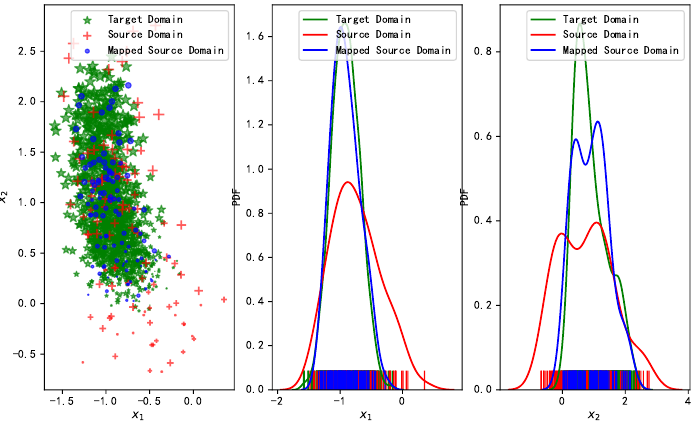
Figure 4. Fingerprint samples in the source domain, in the target domain, and after mapping from the source domain to the target domain with OT ( left ), the corresponding fitted distributions of features ( center and right ).